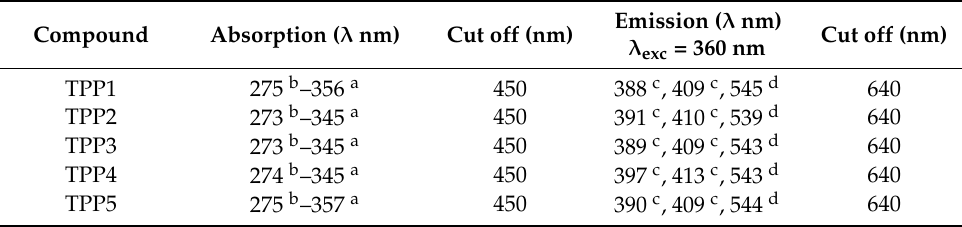
Figure 8. Normalized absorption spectra of the polymers in thin film deposited on ITO/glass. Reproduced with the permission of Reference [35]. Copyright Creative Common CC BY license. Table 1. Optical Properties of polymers deposited on ITO/glass. Reproduced with the permission of Reference [35]. Copyright Creative Common CC BY